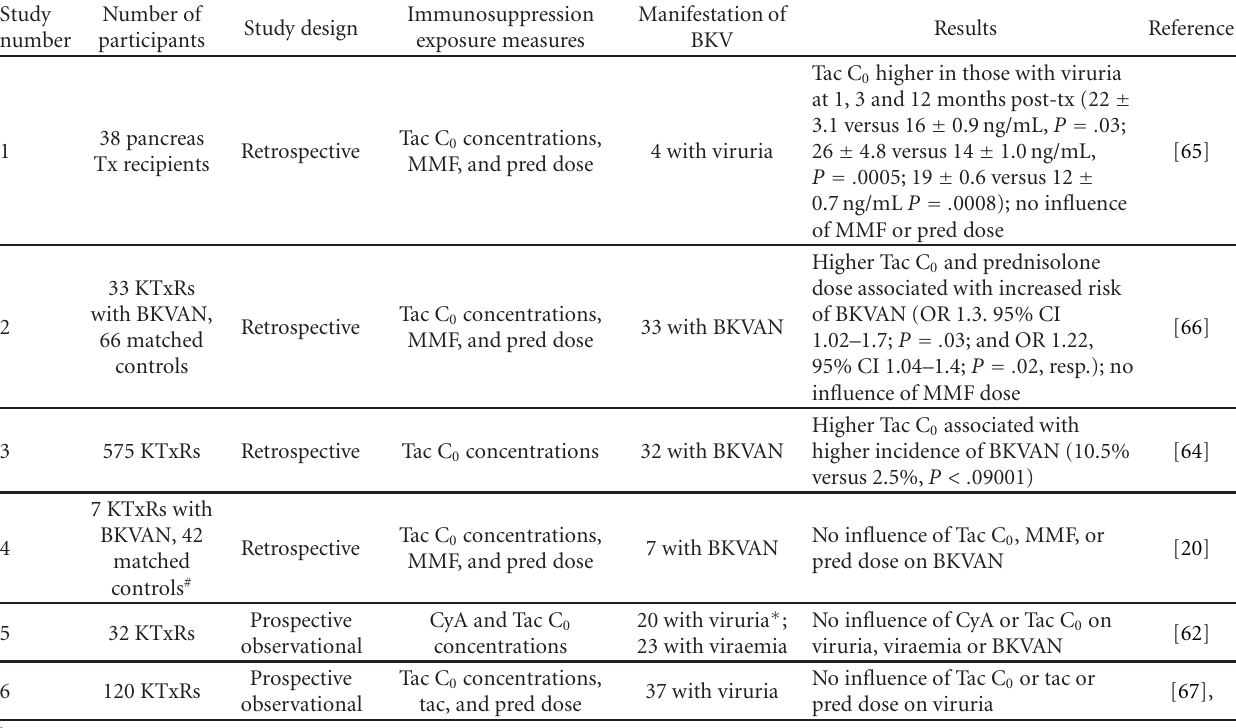
Table 3: Clinical studies examining the relationship between BKV replication and drug